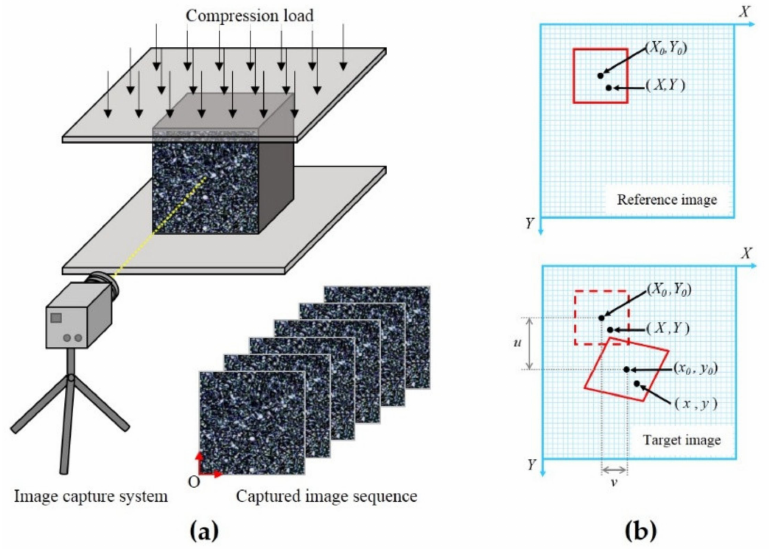
Figure 3. Digital speckle image capturing and schematic of DIC method for the concrete specimen. ( a ) Diagram of experimental setup; ( b ) correlation registration schematic based on DIC